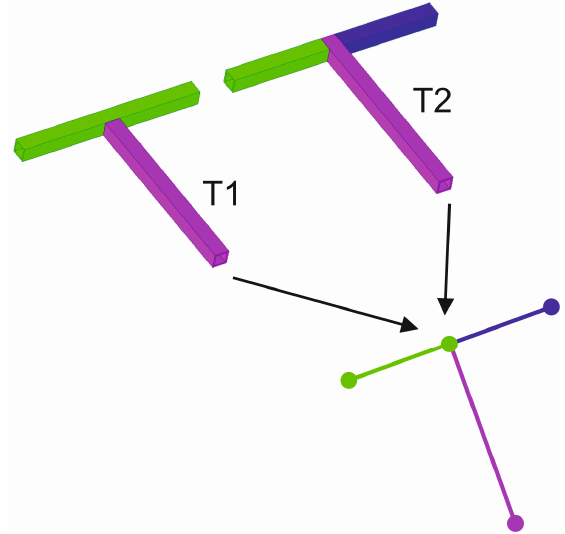
Figure 1. T-junctions equivalent beam-type element model. T1 junction with two elements (green and purple) and T2 with three elements (green, purple and dark blue).